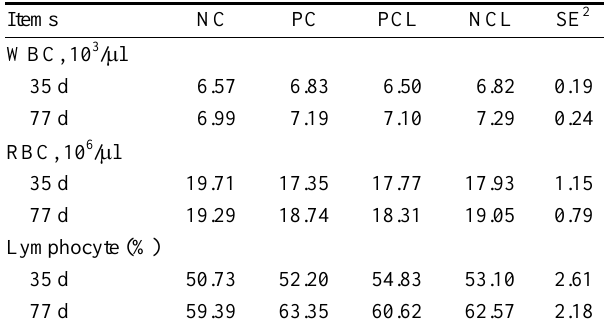
Table 4. Effect of low fermentable carbohydrates (FC) on